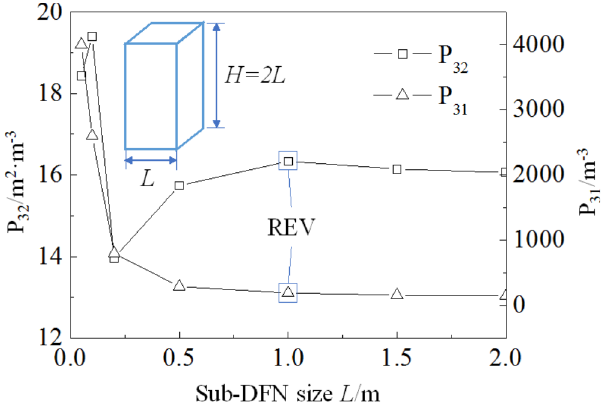
Fig. 3 Varieties of P 32 and P 31 with respect to the sub-DFN size